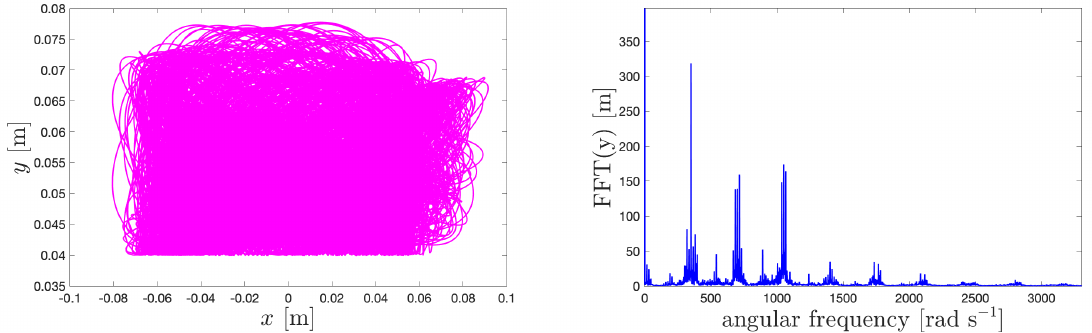
Figure 11. Investigated system’s (1) phase diagram and FFT( y ) for e T = 0.015 m, ω = 2.2 rad s − 1 , and z a = 0.0028 m.